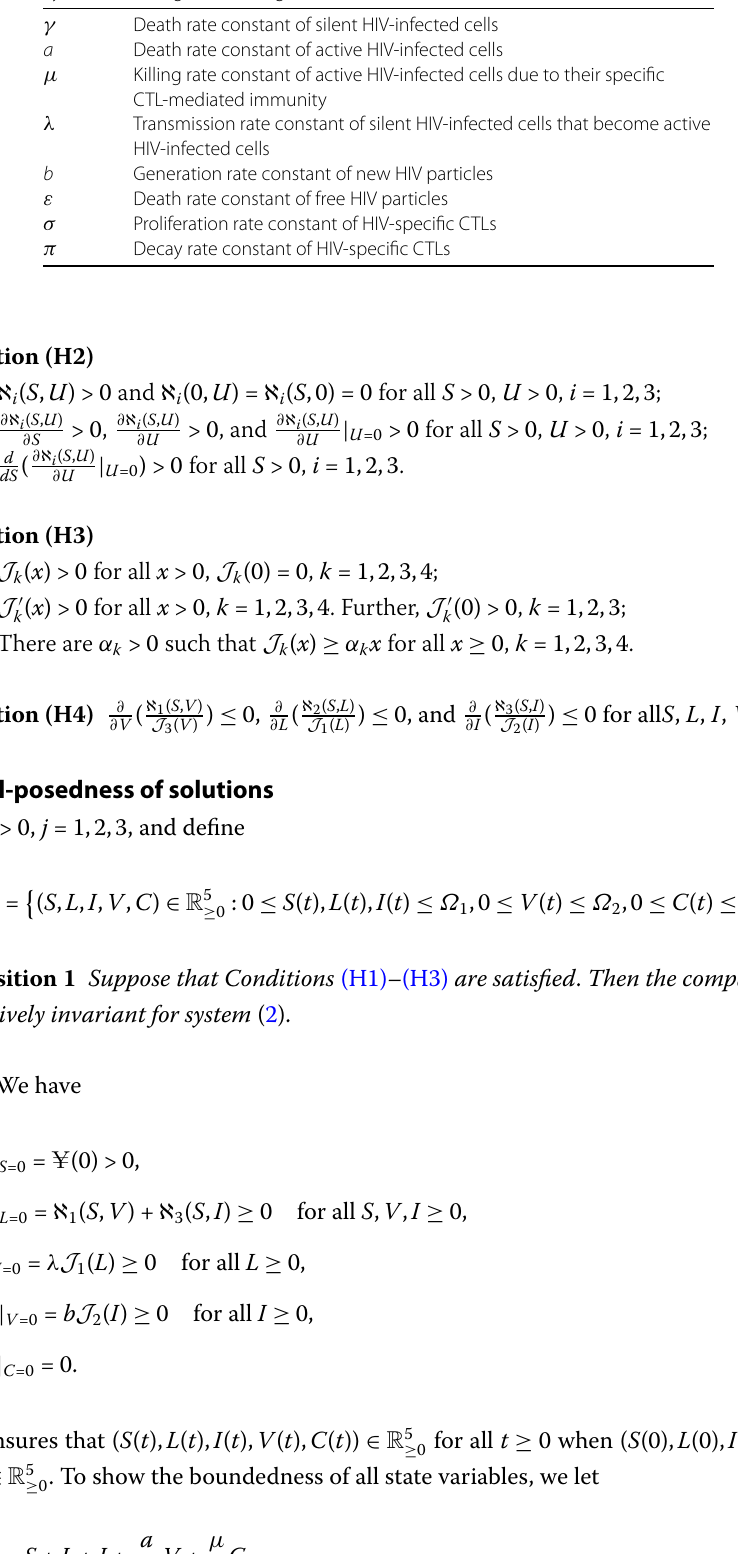
Table 1 Parameters of model (2) and their interpretations Symbol